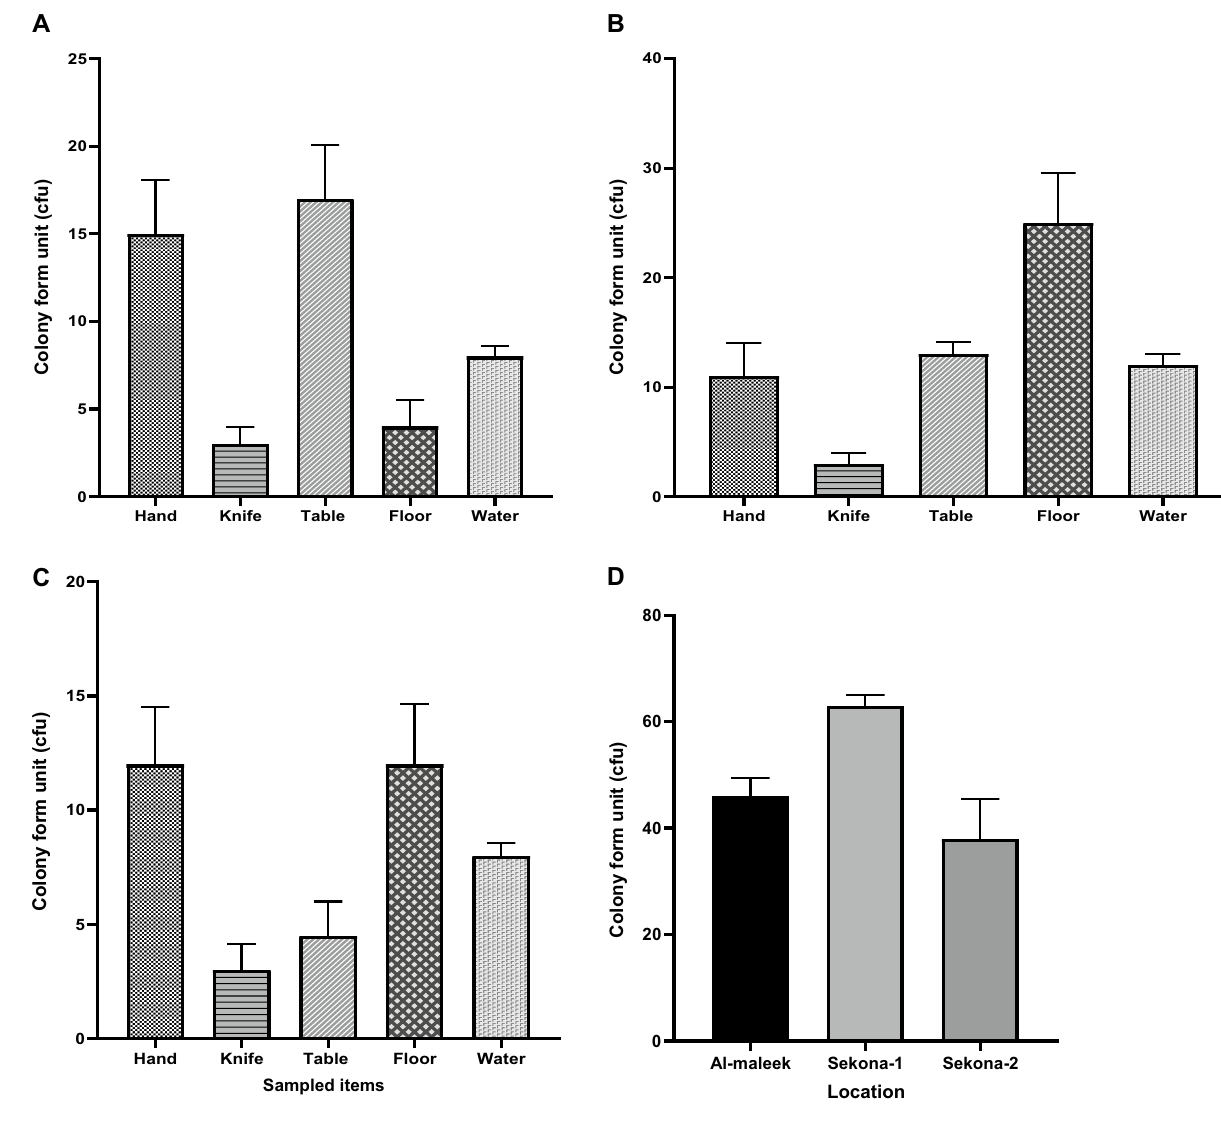
Figure 1. Average colony counts (cfu/ml) of E. coli colonies at the respective sampling locations (Workers’ hands, slaughtering knife, slaughtering tables, floor and effluent water) in Al-maleek ( A ), Sekona-1 ( B ), Sekona-2 and in all three sites ( D ) pooled